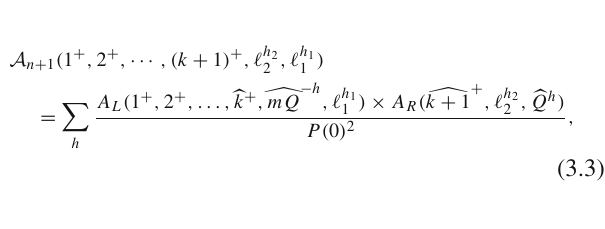
The other advantage is that we can reduce (3.1)